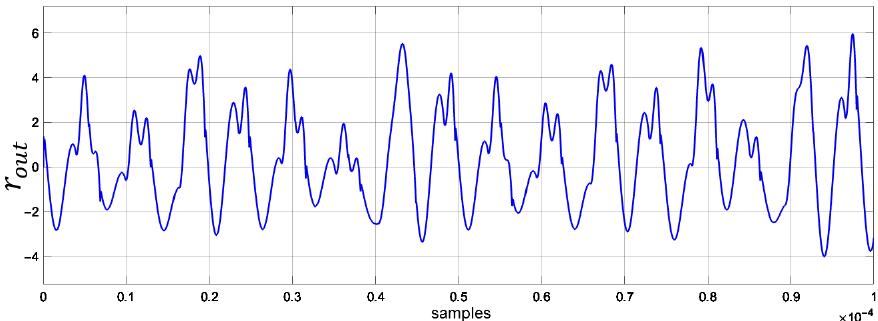
Figure 2. Waveforms at the output of the chaos generator.